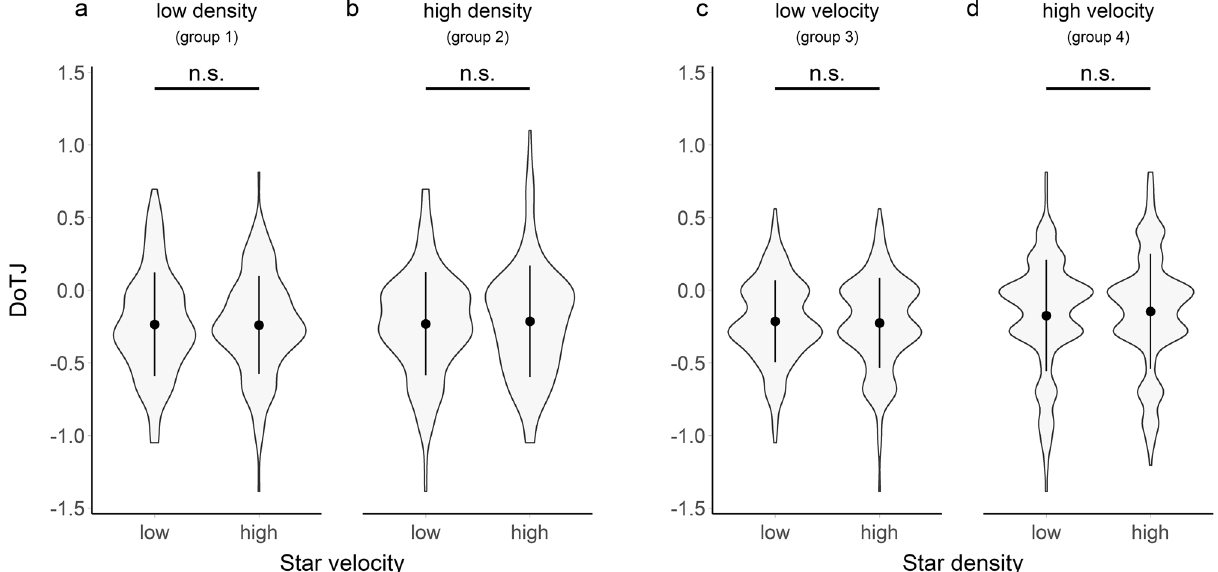
Figure 4. Violin plots of proportional deviation estimates (log(estimated duration/duration)) of DoTJs (data from groups 1–4). In the groups 1 & 2 ( a , b ) the velocity of stars was manipulated (within-subject manipulation), while density was kept at a constant level (Group 1: low; Group 2: high). In the groups 3 & 4 ( c , d ) the density of stars was manipulated (within-subject manipulation), while velocity was kept at a constant level (Group 3: low; Group 4: high). Proportional duration estimates > 0 can be interpreted as overestimations of interval durations while values < 0 mean an underestimation of interval durations. Central dots indicate the means over all subjects, central vertical lines indicate the sd. Asterisks indicate significant pairwise Tukey post-hoc test (* < 0.05; ** < 0.01, *** < 0.001, n.s.: not significant), corrected for multiple comparisons.